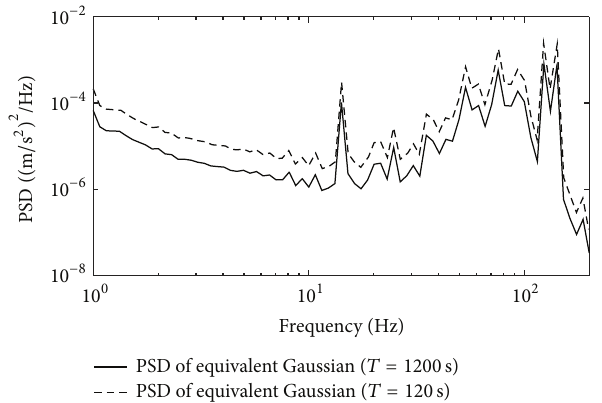
Figure18:PSDofequivalentGaussiansignalwithdifferentduration time.